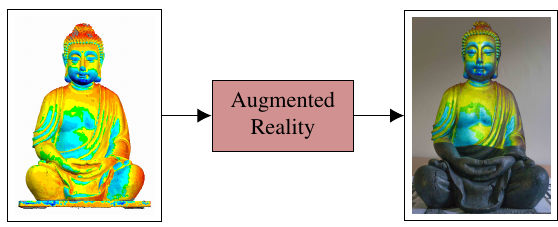
Figure 1. Schematic representation of a projector-based aug- mented reality application. Some color coded 3D information related to an object (left) is directly projected onto the object it- self (right) to simplify an inspection task for the